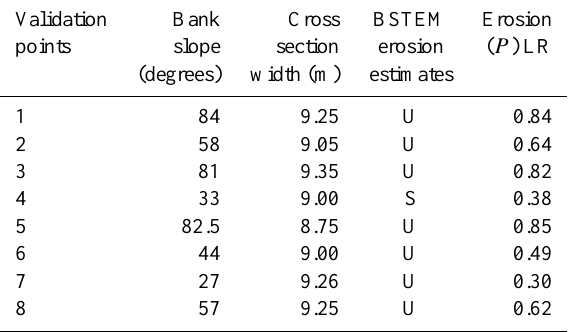
Table 3. Result of LR application at the eight validation locations (Fig. 1). The independent variables used and the BSTEM estimates are also presented. In the fourth column, S denotes stable and U unstable bank locations.